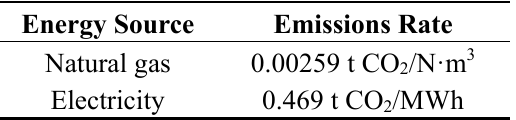
Table 9. CO 2 emissions factors by energy source.